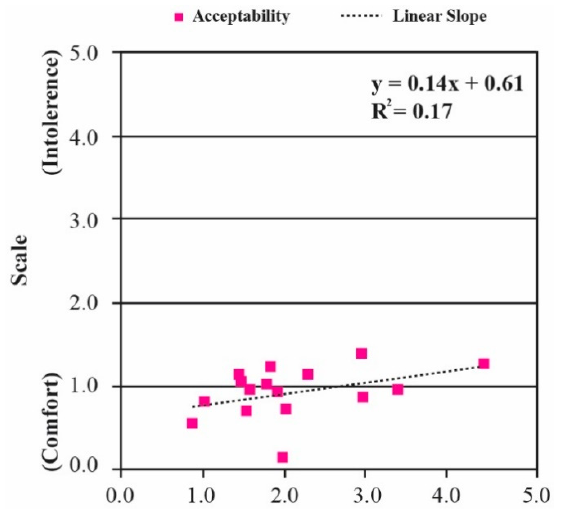
Figure 7. Indoor air quality acceptance according to the CO 2 concentration.